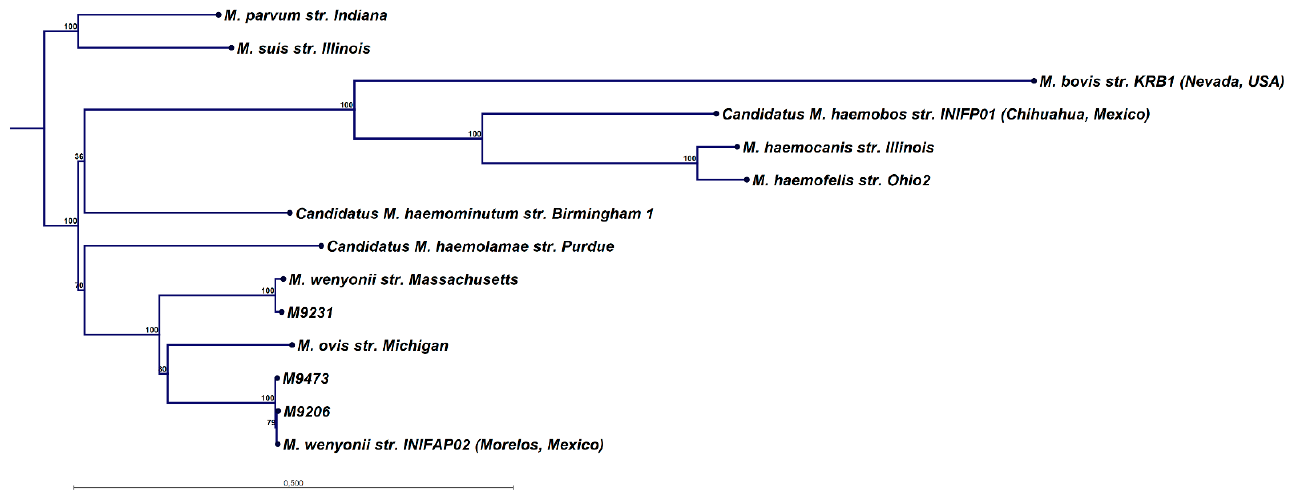
Figure 1. Maximum likelihood phylogenetic tree of the polC polymerase near-complete amino acid sequences (range: 1407-1331 aa) from three samples of the present study (M9231, M9473 and M9206) and various reference samples from GenBank. Percentage bootstrap support of 1000 replicates is shown. The scale bar indicates the average number of substitutions per site.